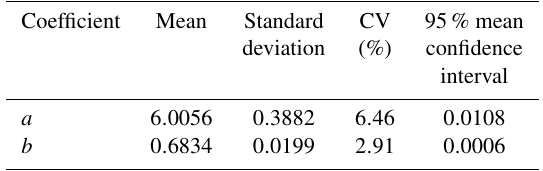
Table 3. Mean, standard deviation, variation coefficient CV and mean 95% confidence interval CI of the coefficients a and b of Eq. (12), computed by performing the second MC simulation. Coefficient Mean Standard CV 95% mean